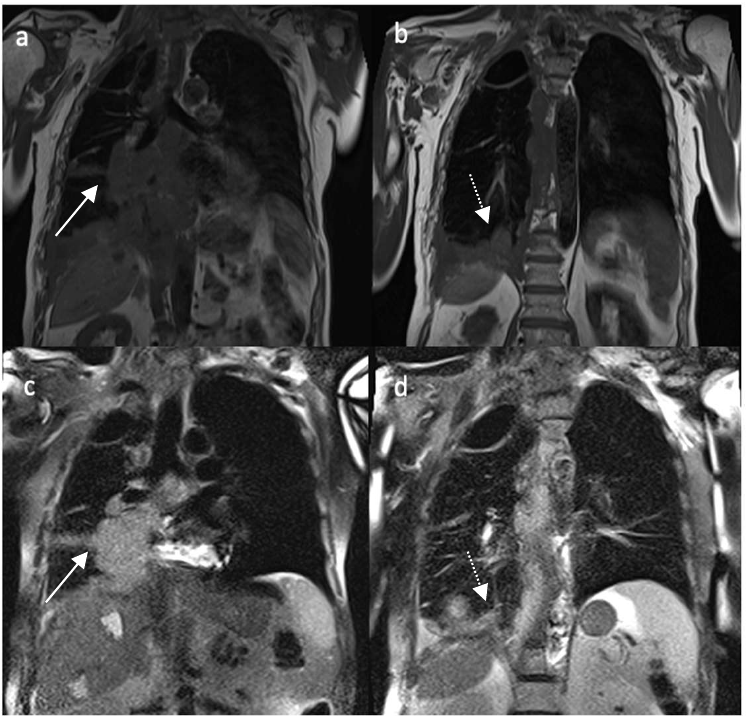
Figure 2. Non-enhanced coronal T1w ( a , b ) and T2w ( c , d ) images of a patient affected by MPM. White arrow in ( a , c ) depicts paramediastinic nodular lesions; dotted white arrow in ( b , d ) portrays diaphragmatic pleural